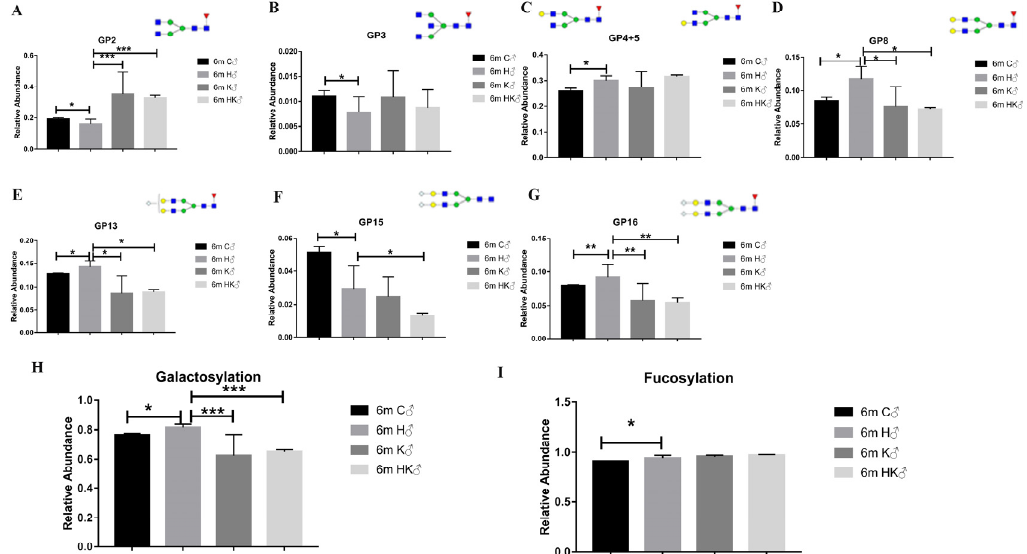
Figure 4. B-cell-specific ablation of B4GALT1 reduces the level of serum IgG galactosylation in HCC and reverses the changes induced in galactose-related glycans in HCC. ( A ) B-cell-specific ablation of B4GALT1 and systemic knockout of B4GALT1 both reversed the changes in the relative abundance of GP2. ( B ) B-cell-specific ablation of B4GALT1 and systemic knockout of B4GALT1 do not affect the relative abundance of GP3. ( C ) B-cell-specific ablation reverses the changes observed in the sum of the relative abundances of GP4 and GP5. ( D ) B-cell-specific ablation of B4GALT1 and systemic knockout of B4GALT1 both reversed the changes in the relative abundance of GP8. ( E ) B-cell-specific ablation of B4GALT1 and systemic knockout of B4GALT1 both reversed the changes in the relative abundance of GP13. ( F ) Systemic knockout of B4GALT1 promoted changes in the relative abundance of GP15. ( G ) B-cell-specific ablation of B4GALT1 and systemic knockout of B4GALT1 both reversed changes in the relative abundance of GP16. ( H ) B-cell-specific ablation of B4GALT1 and systemic knockout of B4GALT1 both reversed changes in the relative abundance of galactosylation. ( I ) B-cell-specific ablation of B4GALT1 and systemic knockout of B4GALT1 did not affect the relative abundance of fucosylation. Structural symbols are the same as Figure 2. Data are expressed as mean ± SD. * p < 0.05, ** p < 0.01, *** p < 0.001. (C—control WT group; H—HCC WT group; HK—HCC B4GALT1 +/ −